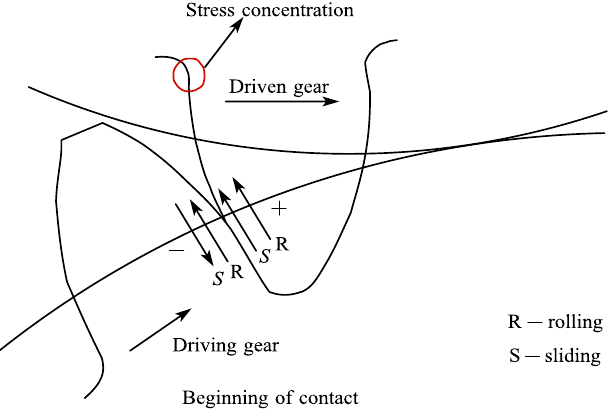
Figure 7. Contact surface between driven and driving gear.